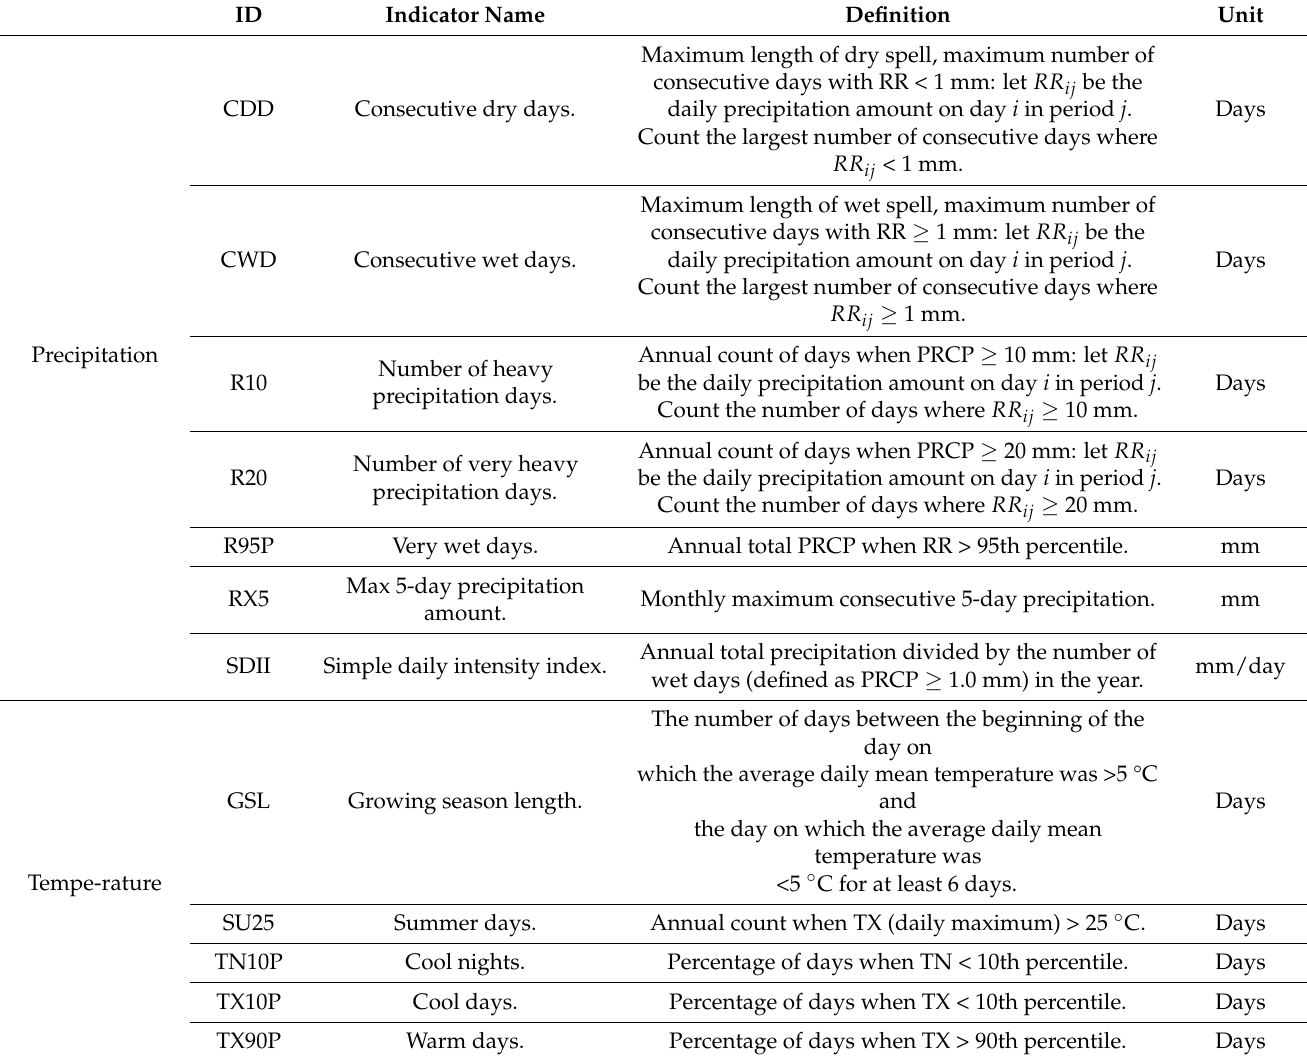
Table 1. Extreme climate